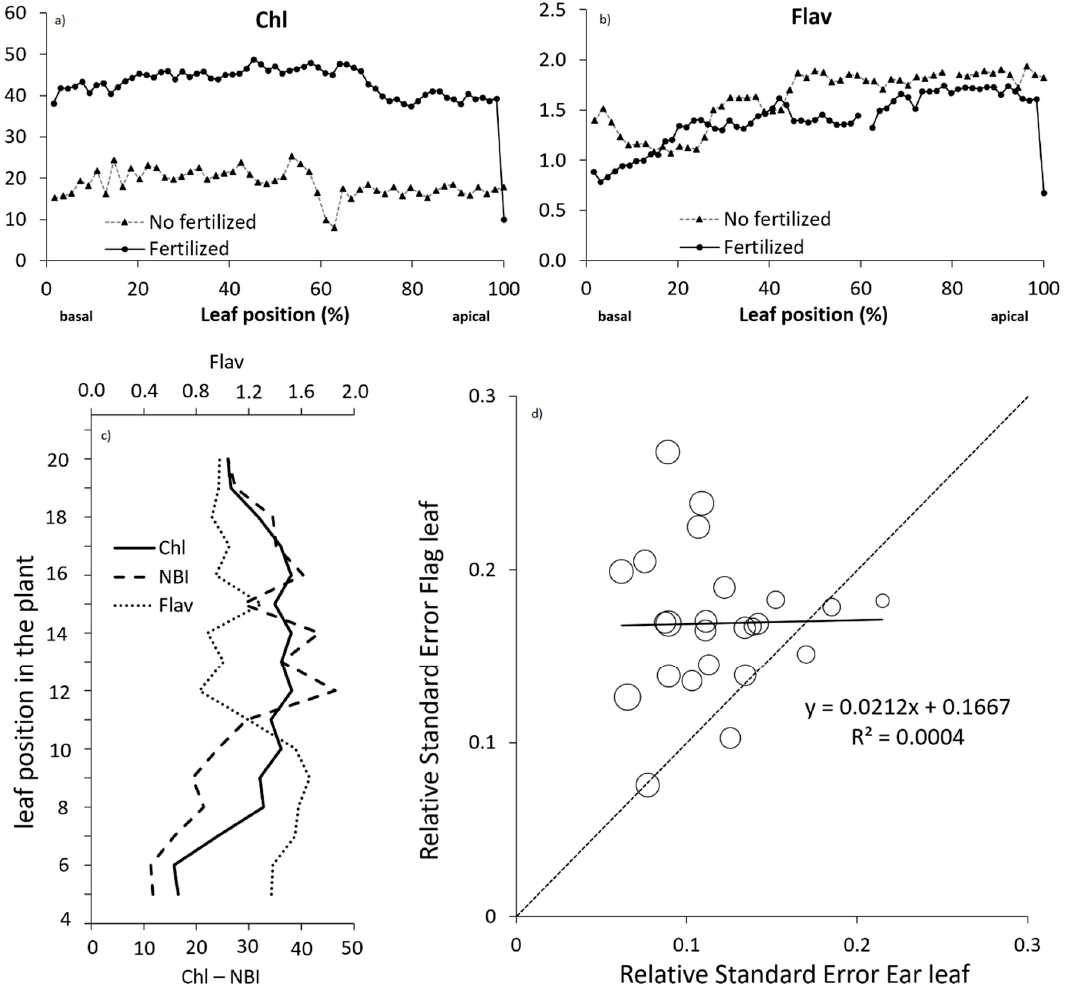
Figure 2. Measurements obtained with Dualex (dimensionless) at different positions during maize anthesis. ( a ) Chl and ( b ) Flav measured along the ear leaf in fertilized or not fertilized maize plants, ( c ) Chl, Flav and NBI measured on each leaf (from the lower remaining leaf to the flag leaf; ear leaf: 14) in a fertilized maize and ( d ) Chl relative standard error observed at the flag leaf and at the ear leaf (larger circles represent larger original Chl values).